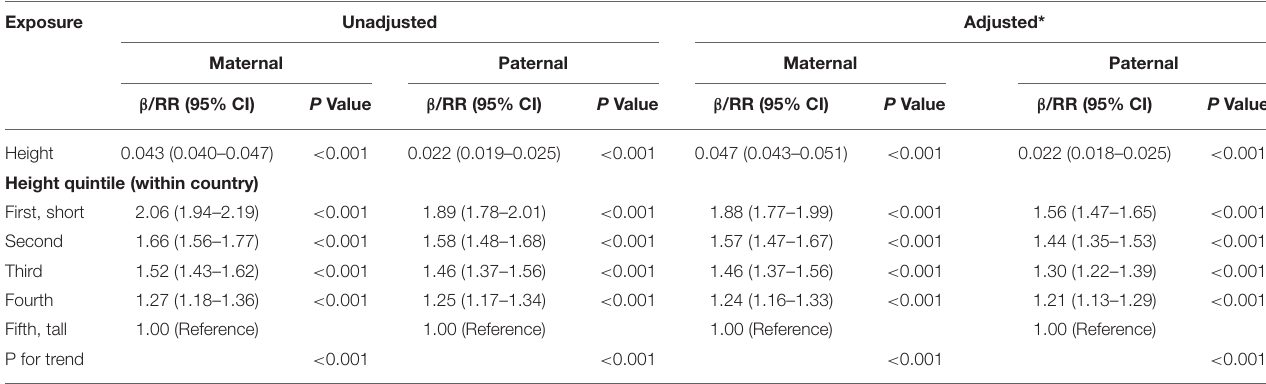
TABLE 2 | Unadjusted and adjusted β between maternal and paternal height and child height-for-age z score (HAZ) and relative risk (RR) between maternal and paternal height quintile and child stunting with their 95% confidence intervals (CIs). Exposure Unadjusted Adjusted* Maternal Paternal